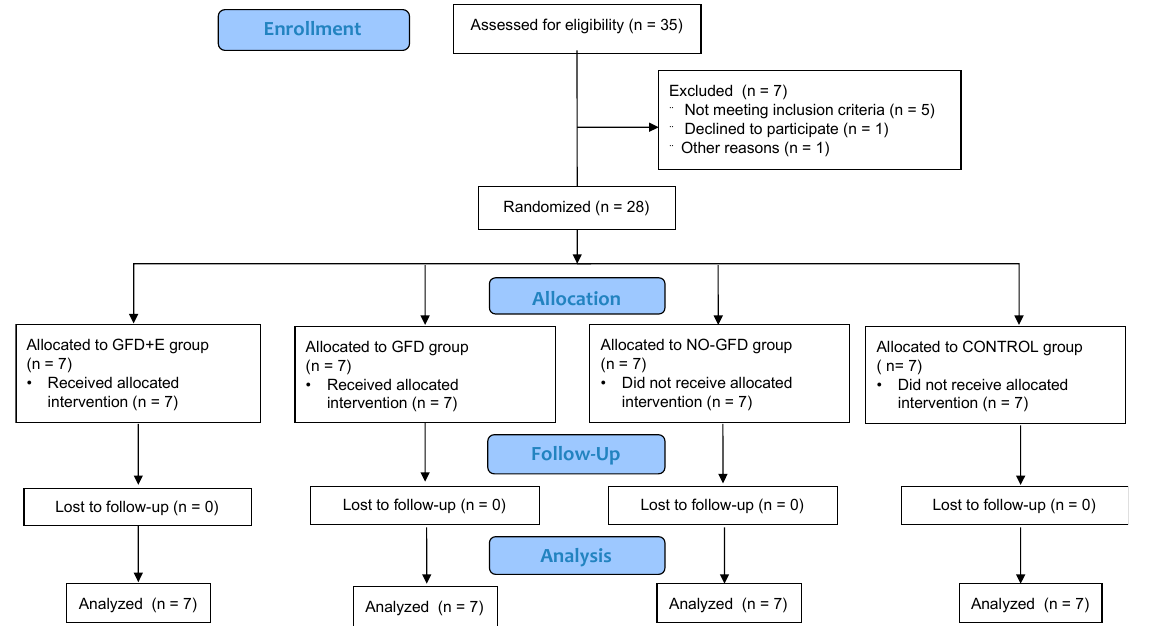
Figure 1. Consort 2010 flow diagram.